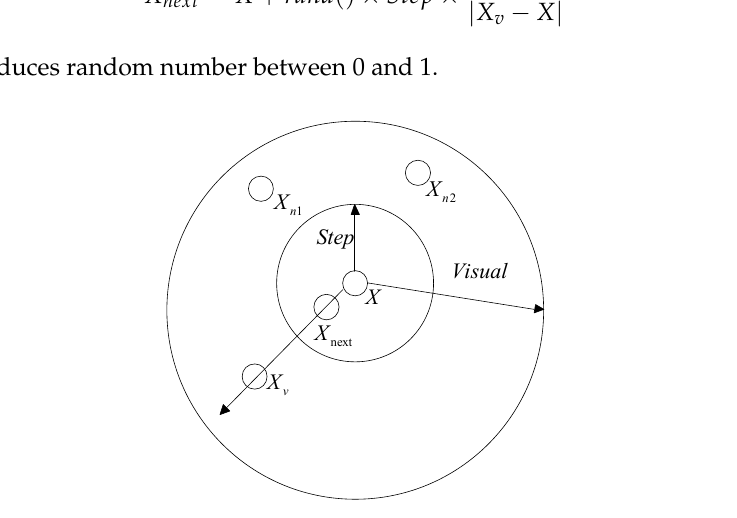
Figure 1. Visual and Step of an artificial fish. X n 1 , X n 2 : Locations of two fish within Visual